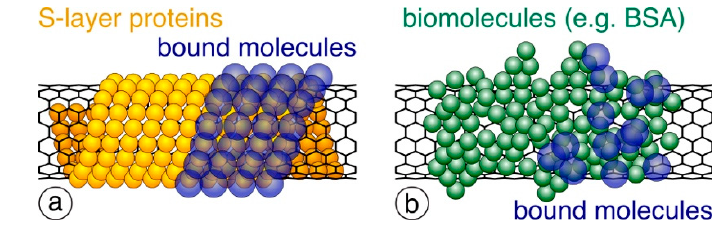
Figure 7. Schematic drawing of ( a ) precisely arranged S-layer proteins (shown in orange) around the CNT surface and ( b ) randomly bound biomolecules (e.g., BSA; shown in green). When used for binding further biomolecules (shown in blue), only S-layers provide a dense and precisely controlled packing.